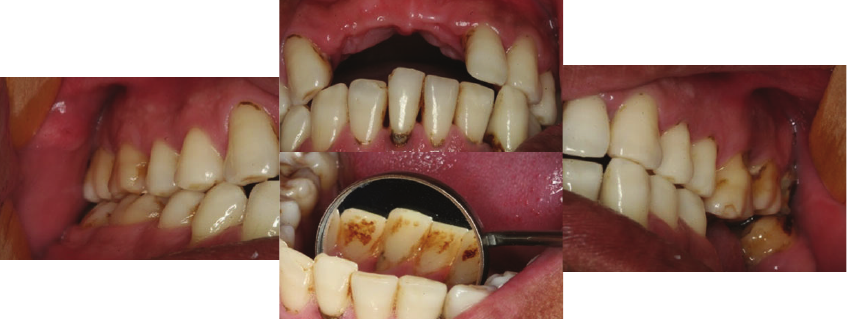
Figure 1: Clinical features of the severe periodontal disease at first consultation. Anterior teeth lost and accumulation of gross calculus and tooth pigmentation.